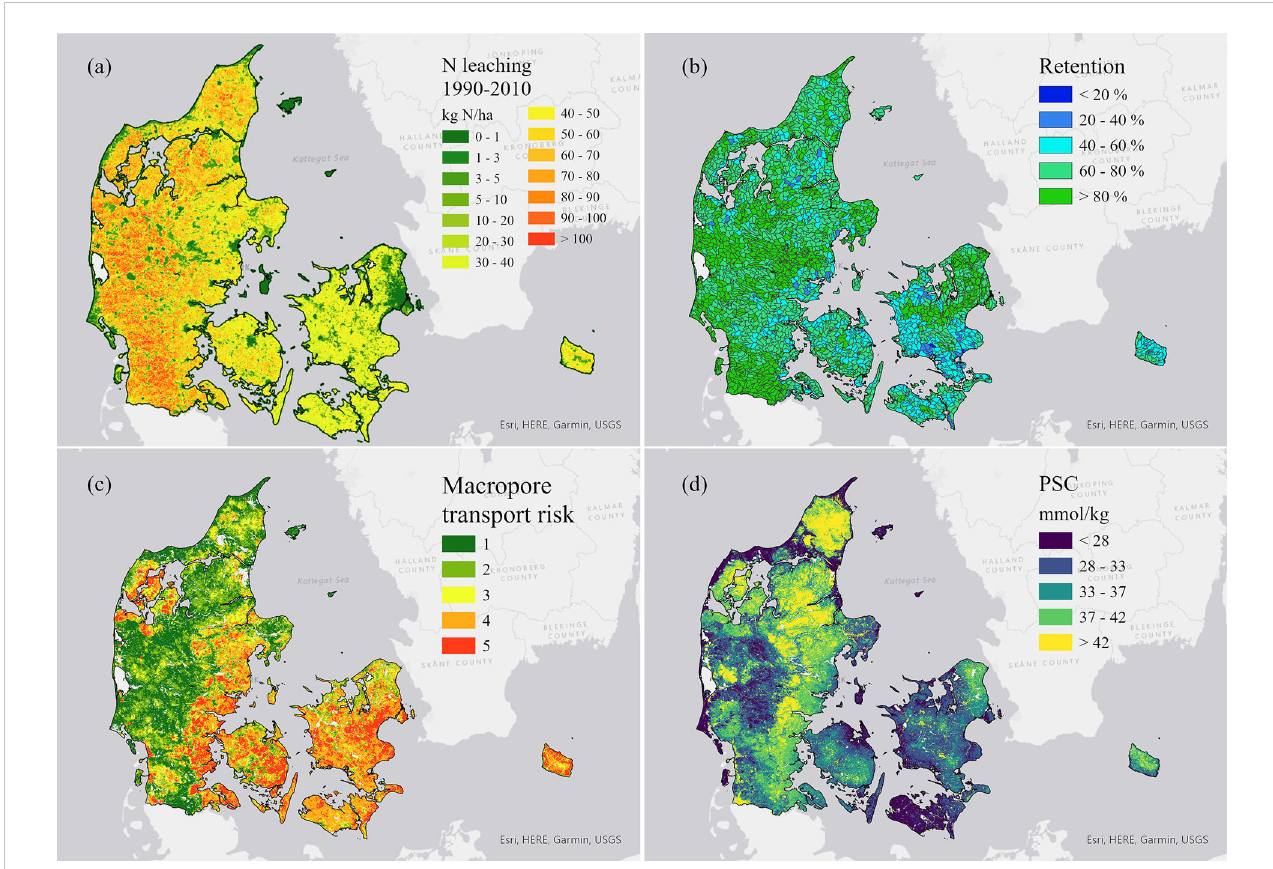
FIGURE 5 Maps of (A) nitrogen leaching, (B) nitrogen reduction, (C) risk of colloid transport in macropores, (D) phosphorus sorption capacity in